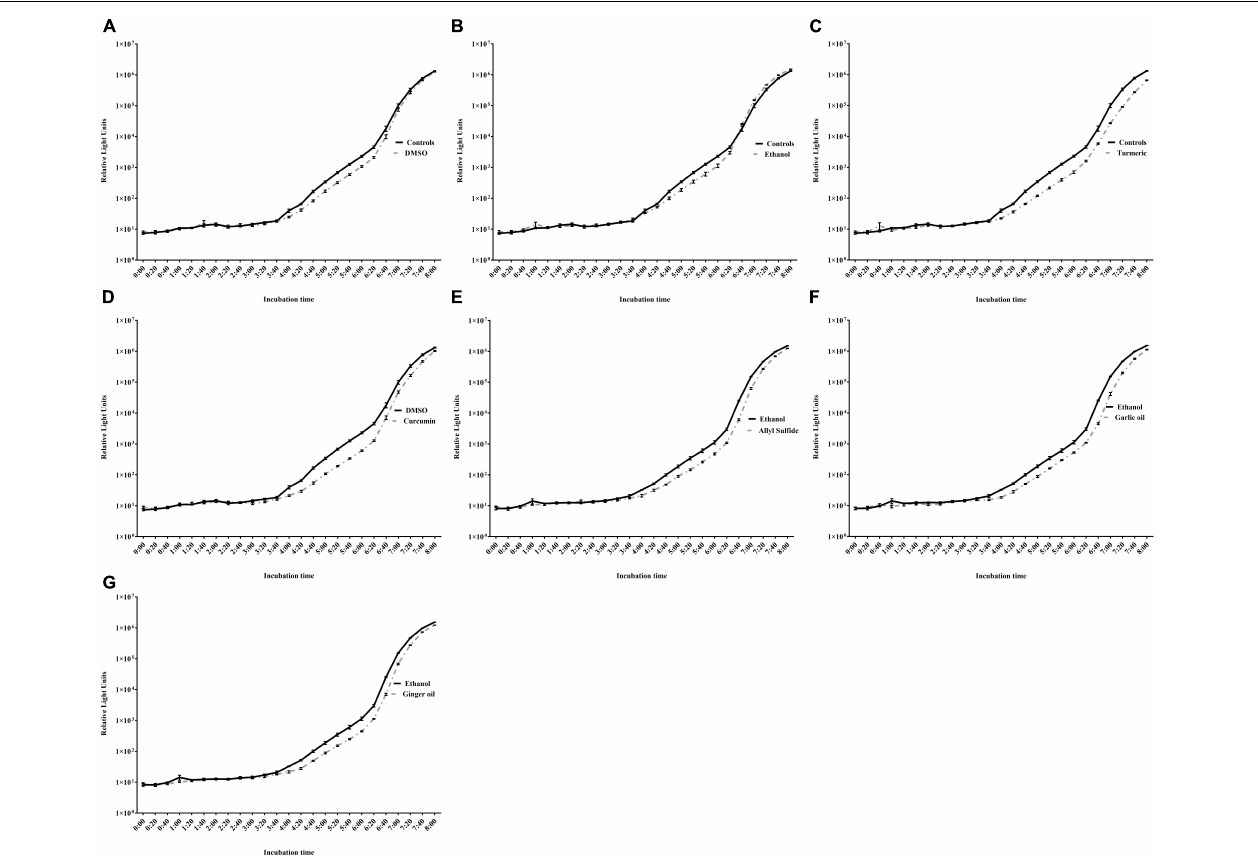
FIGURE 6 | Effect of DMSO (A) , ethanol (B) , turmeric (C) , curcumin (D) , allyl sulfide (E) , garlic oil (F) , and ginger oil (G) at SIC dose on AI-2 levels of C. jejuni S-8 determined by bioluminescence assay. Results are averages of two independent experiments, each containing triplicate samples (mean and